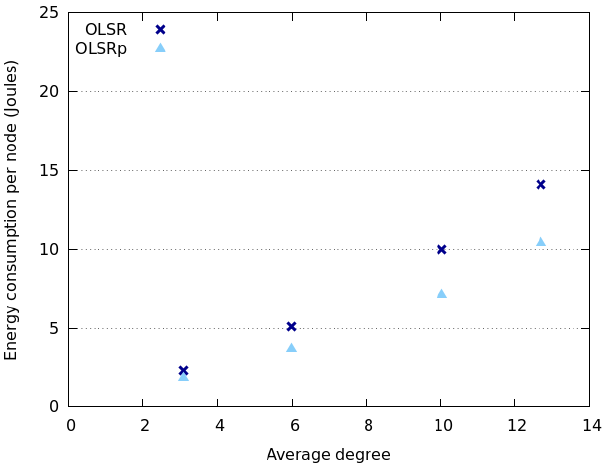
Figure 7. Energy consumption versus network degree when nodes follow a SLAW